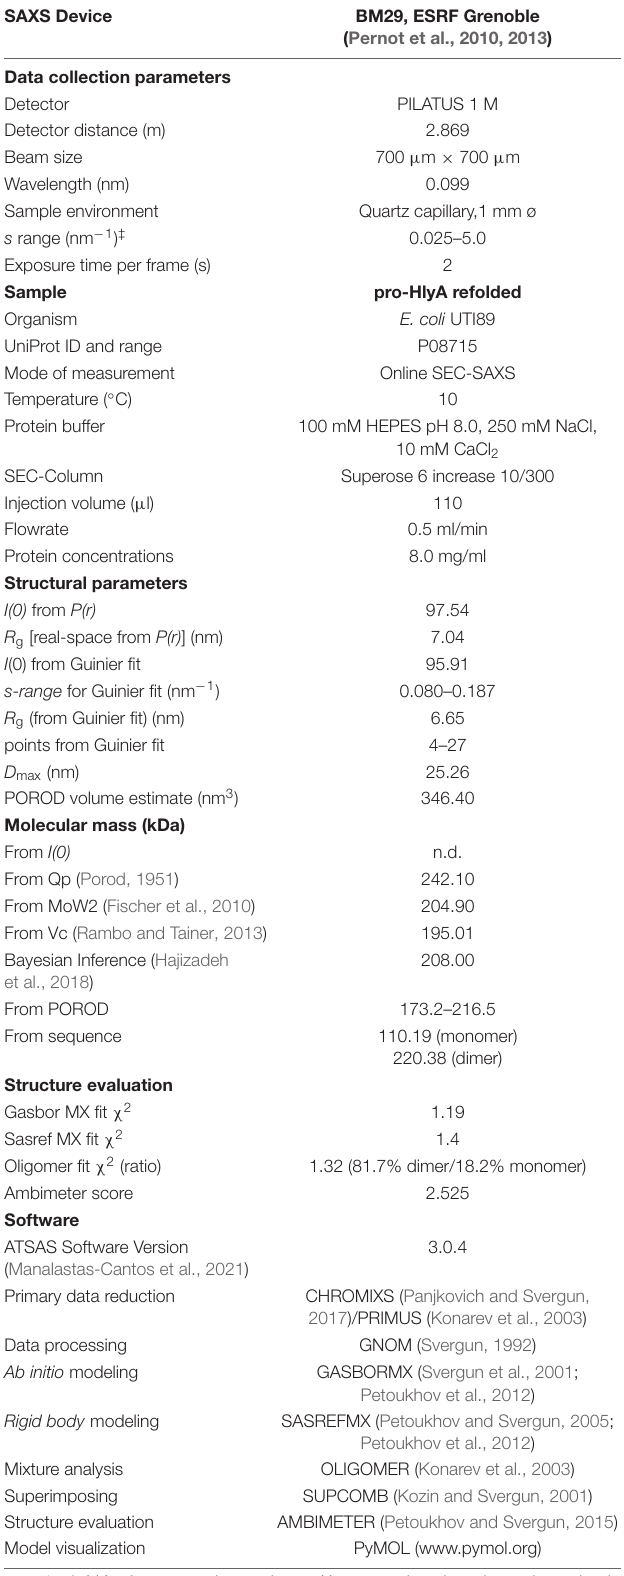
TABLE 2 | Overall small angle X-ray scattering (SAXS) Data of pro-HlyA.